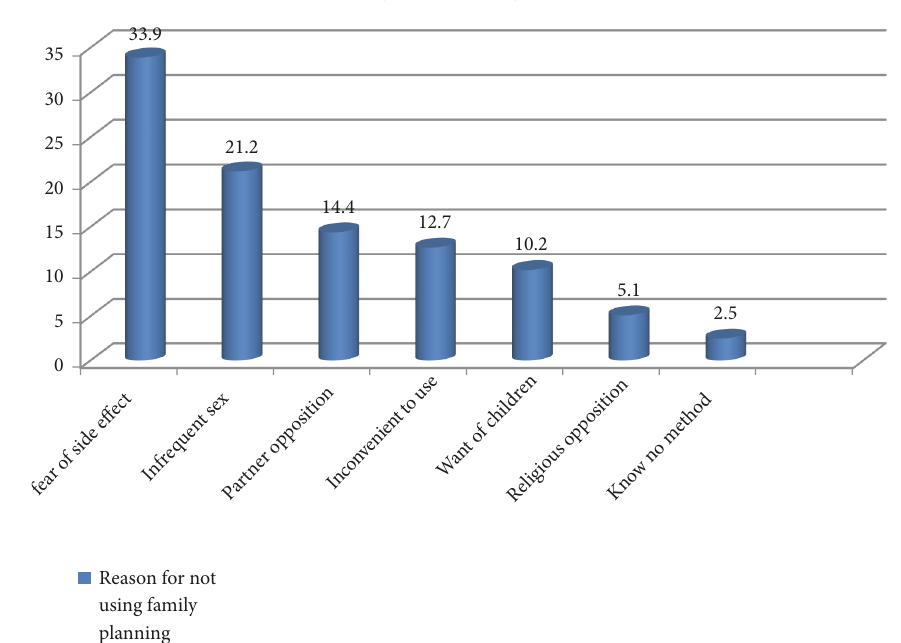
Figure 1: Study participants reason of not using family planning method among abortion service clients in Dessie, Amhara regional state, Ethiopia,